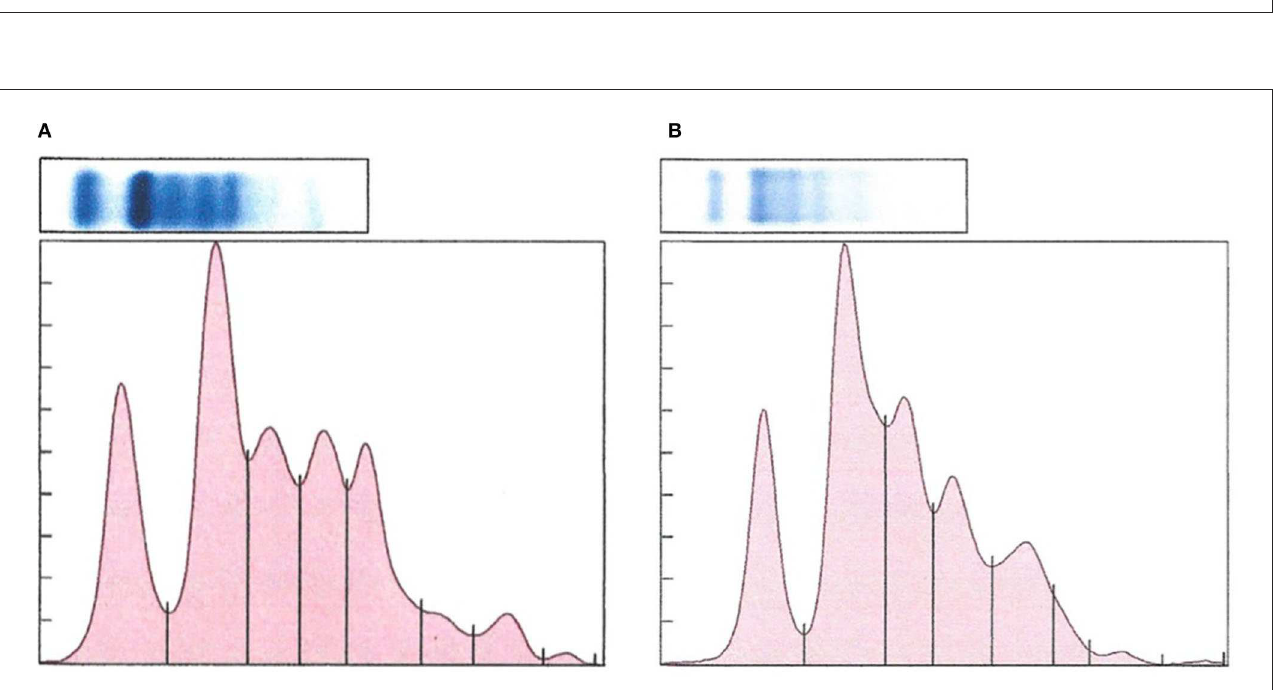
FIGURE12 Representative protein electrophoretograms from a control (A) and a Batrachochytrium salamandrivorans infected, clinically diseased (B) Taricha granulosa .